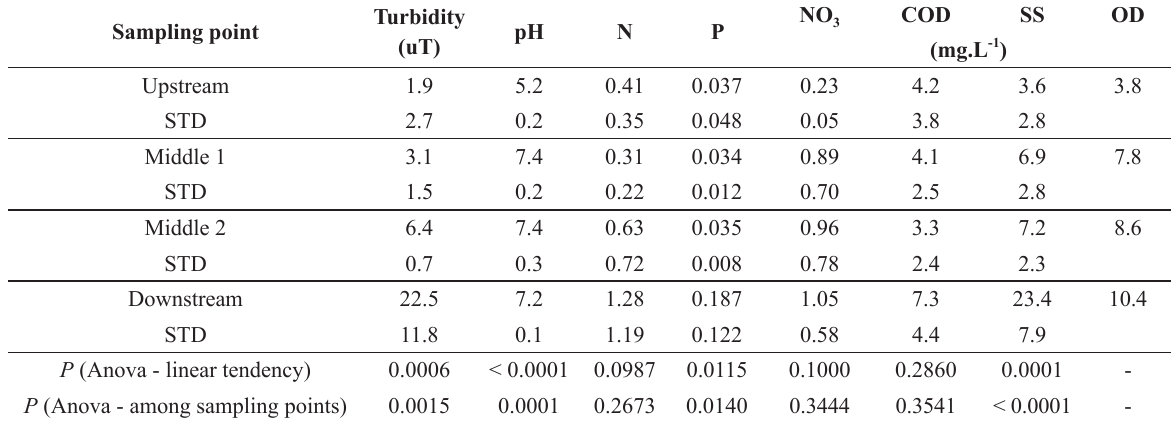
Average of physical-chemical characteristics along the Pardinho